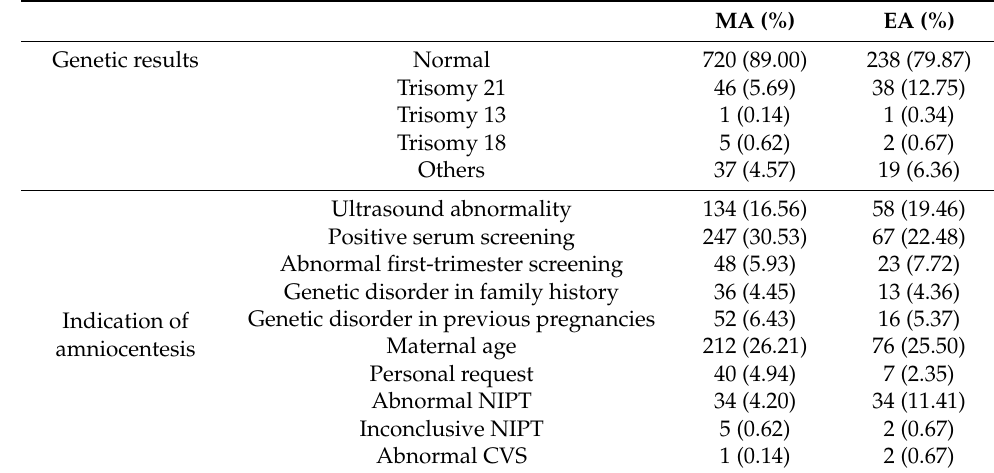
Table 2. Patient